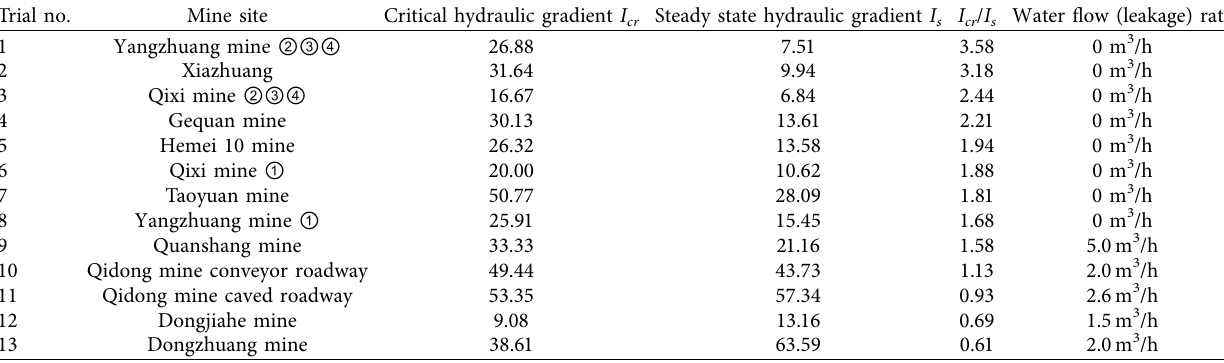
Table 9: Calculated I cr / I s ratio and observed water flow rate (leakage) around bulkheads in different mines in China. Trial no.